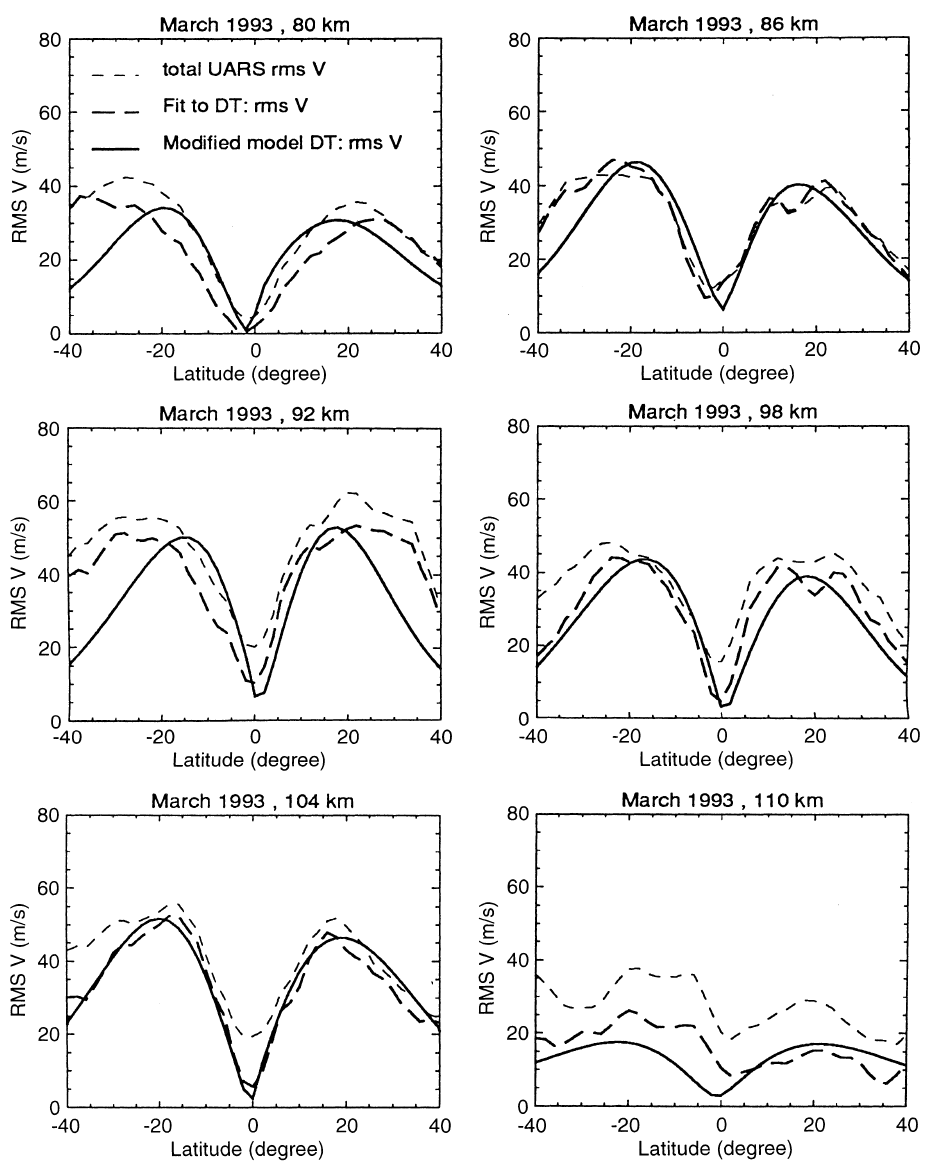
Fig. 3. Latitudinal structures of the RMS meridional (V) winds at di(cid:128)erent levels for March 1993. The dashed thin line is the total daytime averaged rms HRDI/ WINDII wind; dashed thick line is the diurnal tide rms wind, derived by least-squares fits to observa- tions; the solid line is the rms wind corresponding to the modified V diurnal amplitudes used in